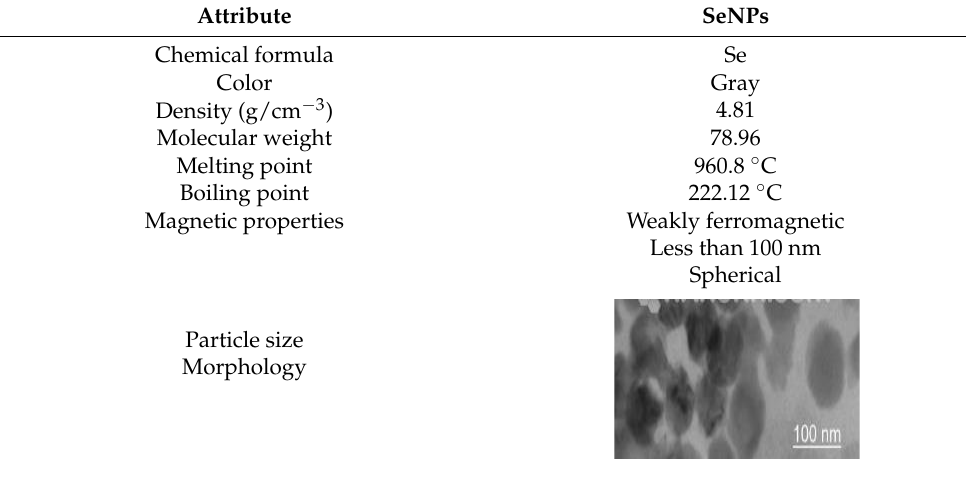
Table 1. Physicochemical characteristics of selenium nanoparticles used for foliar fertilizing the grass ( Festuca arundinacea Schreb .) in a 90-day greenhouse experiment.